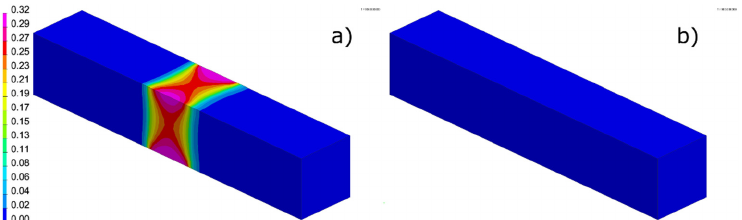
Figure 15. The calculated martensite distributions for: ( a ) TC0—maximum 31.5% and ( b ) TC1—0.4%, (others 0%).